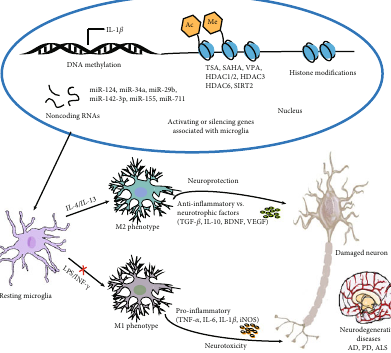
Figure 1: Possible mechanisms underlying epigenetic modulation of microglia in neurodegenerative diseases. Microglia-mediated neuroin fl ammation is a prominent feature of neurodegenerative diseases. Microglia exert neuroprotective and deleterious e ff ects in neurodegenerative diseases that may be a ff ected by their distinct phenotypes. Epigenetic mechanisms including DNA methylation, histone modi fi cations, and noncoding RNAs are closely associated with neurodegenerative diseases. Dysregulated epigenetics on microglia-related genes may a ff ect the function of microglia, resulting in neuroin fl ammation and neuronal damage, and exacerbating the progression of neurodegenerative diseases. Epigenetic modulation of microglia hyperactivation or their function and phenotypes, and consequently attenuating in fl ammatory responses and neuronal damage, may be a potential strategy to reverse neurodegenerative